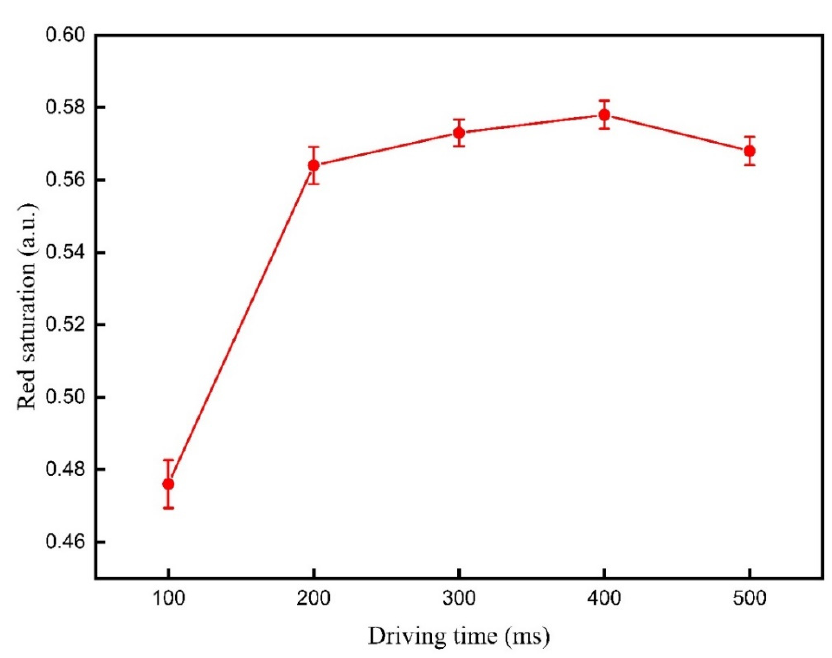
Figure 6. The red saturation of the three-color EPD when it was driven by different driving times of T A 1 . It was increased with the increase of T A 1 from 100 to 400 ms, and the red saturation was decreased when T A 1 reached 500 ms.